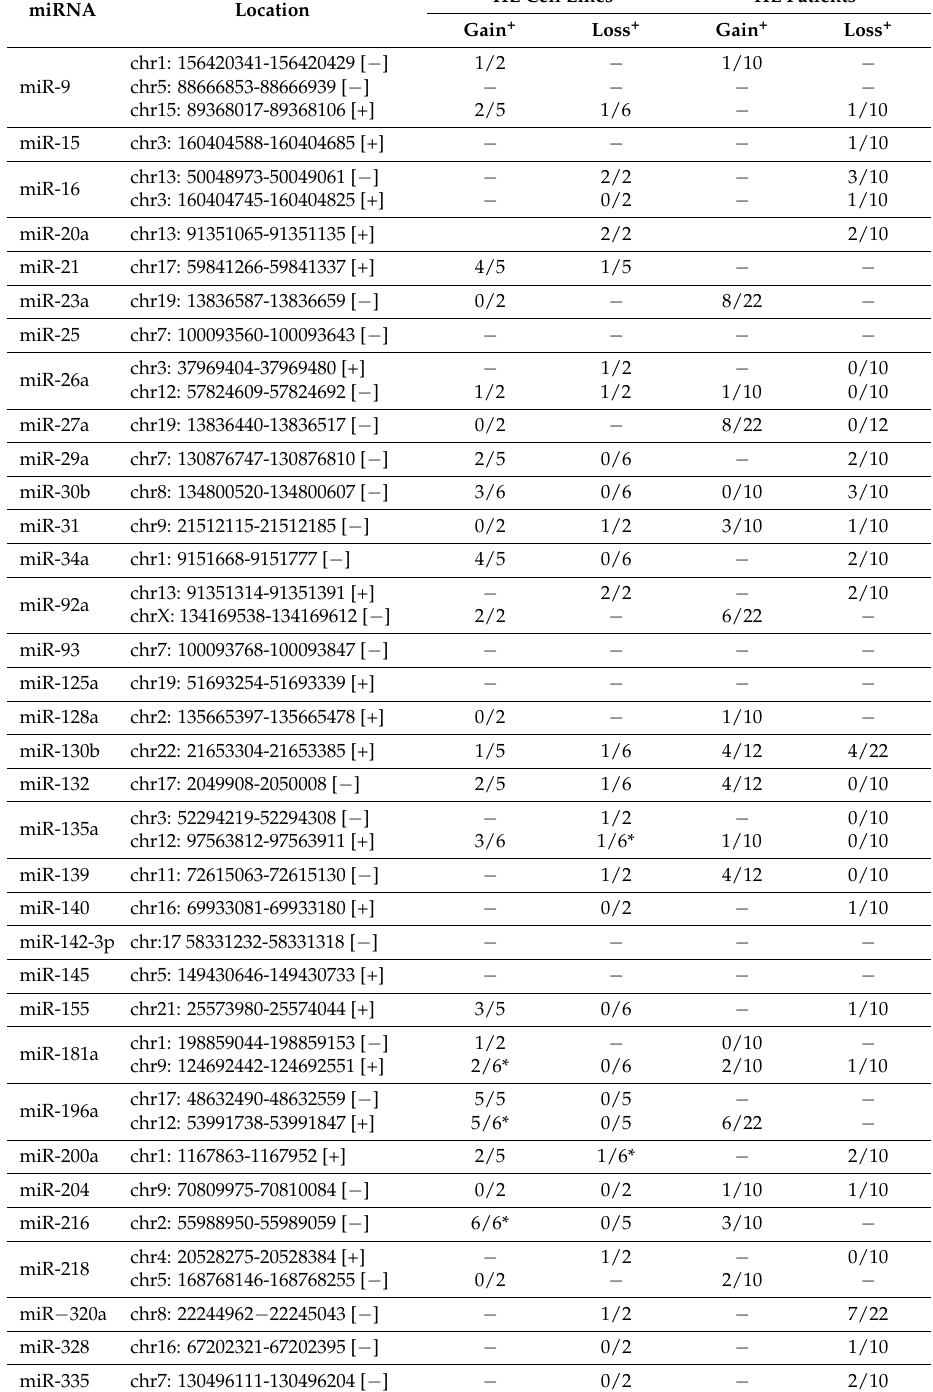
Table 3. Genomic changes (copy number variation) associated with miRNAs identified in at least two HL signatures. This table summarizes the data in the studies of Hartmann et al. [57], Reichel et al. [58], and Hudnall et al. [59]. Genomic location was provided using human genome